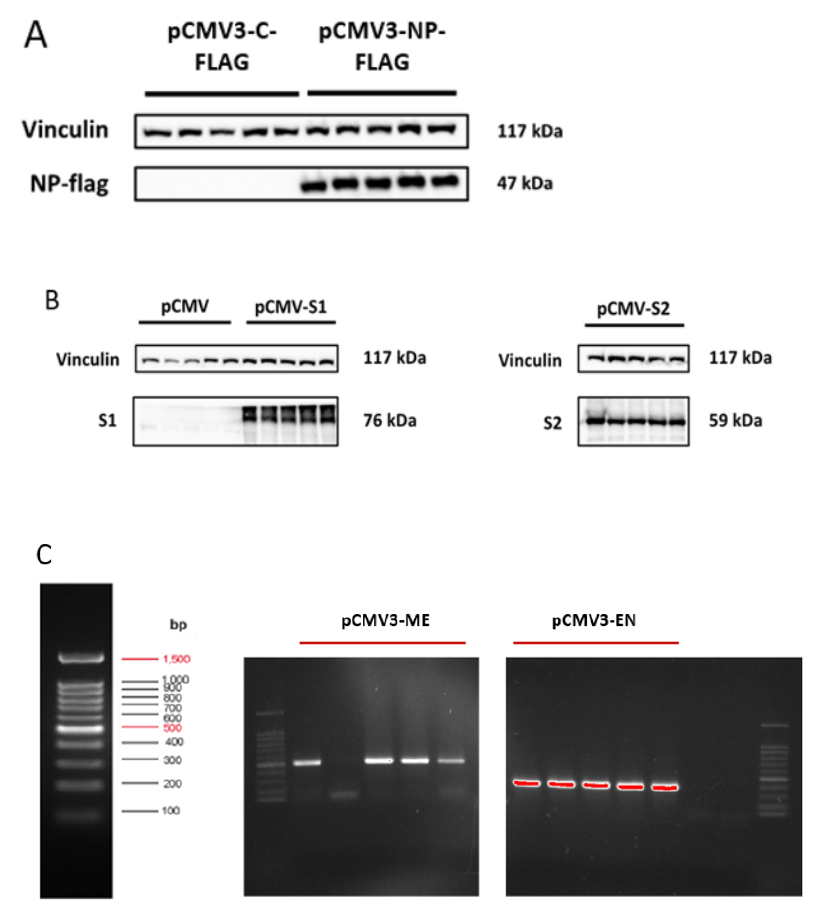
Figure 1. Confirmation of expression following plasmid transfection via Western blotting for ( A ) NP and ( B ) S1 and S2 proteins of SARS-CoV-2. ( C ) Direct PCR amplification followed by agarose gel electrophoresis exhibiting target amplicons for NSP16 (ME) and NSP15 (EN) transfections, which are absent in controls in the two lanes to the right of pCMV3-EN. The DNA size markers are shown in bp.